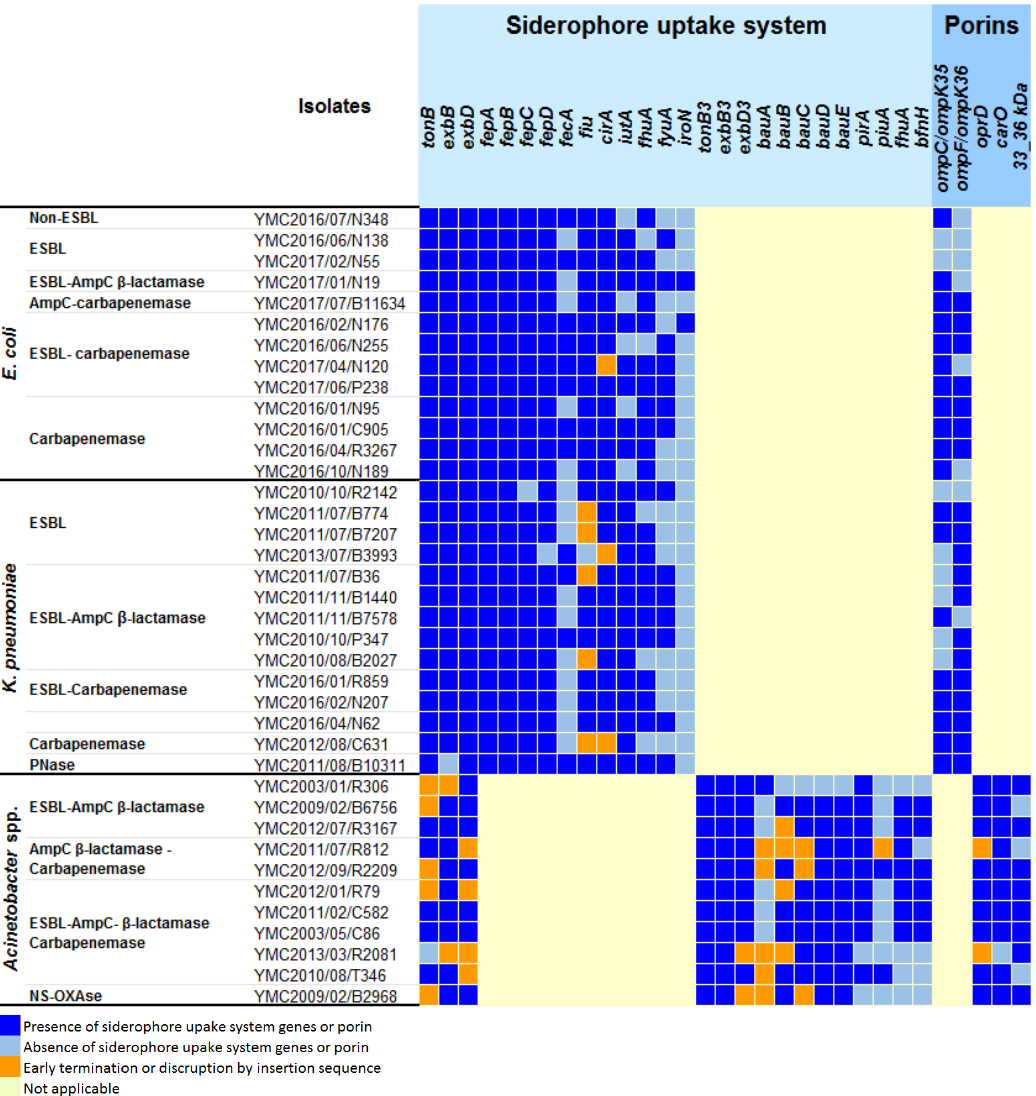
Table 2. Porins and siderophore uptake systems of E. coli , K. pneumoniae and Acinetobacter spp. panel strains.